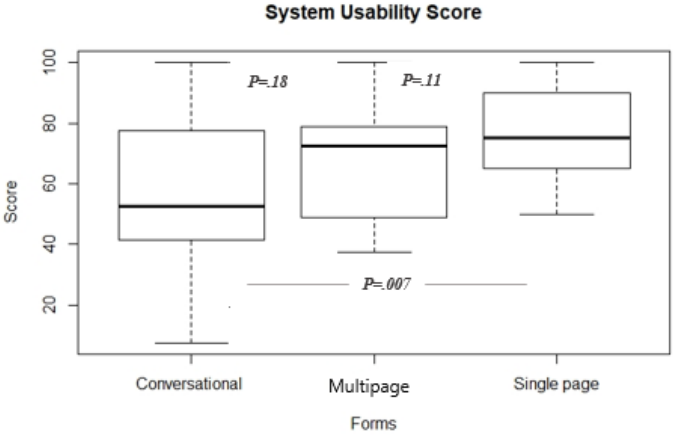
Figure 6. Boxplot for the average System Usability Scale score of each form. The single page had a mean System Usability Scale score of 76 (SD 15) and outperformed the usability of the multipage and conversational forms with mean System Usability Scale scores of 67 (SD 17) and 57 (SD 24), respectively. Even with a β coefficient of .015, the results are still